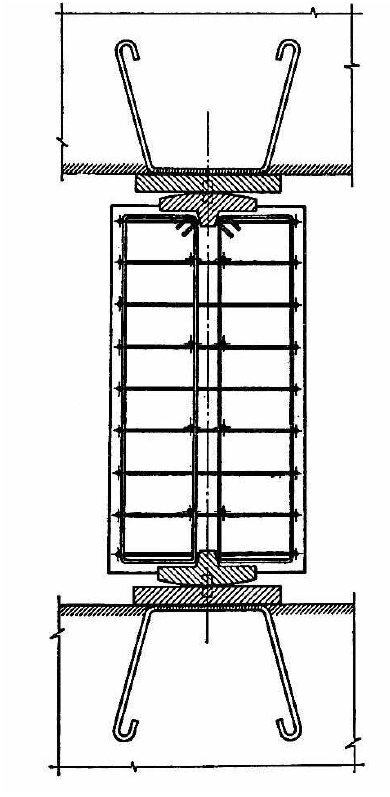
Figure 8. Concrete pendulum bearing typical scheme (Pozzati and Ceccoli, 1977, fig. 3.38, p.